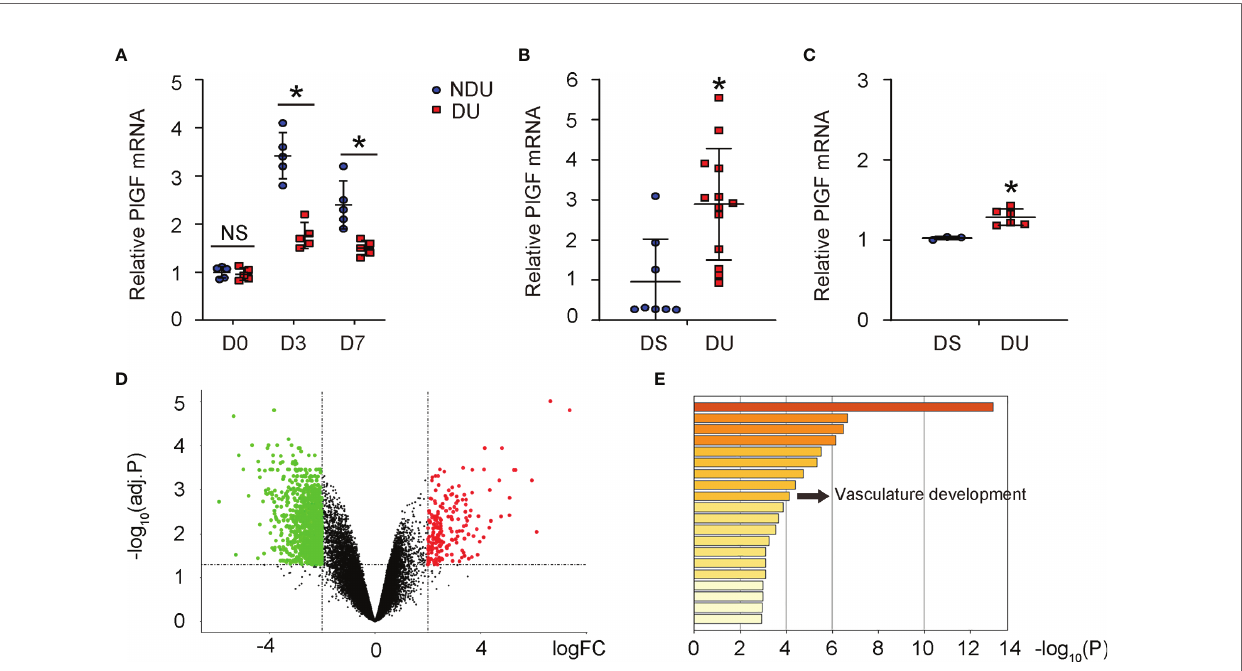
FIGURE 1 | PlGF upregulates during foot wound healing and this upregulation is compromised in diabetes. (A) ELISA for PlGF in diseased foot tissue from a mouse model for DFD before induction of ulcer (day 0) and day 3 and day 7 after induction of DFD in mice. DU: diabetic ulcer. NDU: non-diabetic ulcer. (B, C) PlGF mRNA levels in diabetic foot skin (DS, equal to DU day 0) versus diabetic foot ulcer (NDU, equal to DU day 3) from human DFD dataset GSE134431 (B) and GSE80178 (C) . (D) A hot map to show difference in gene expression from DS versus DU in GSE80178. (E) A pathway analysis to show difference in enriched pathway between DS and DU in GSE80178. *p < 0.05. NS, non-signi fi cant.